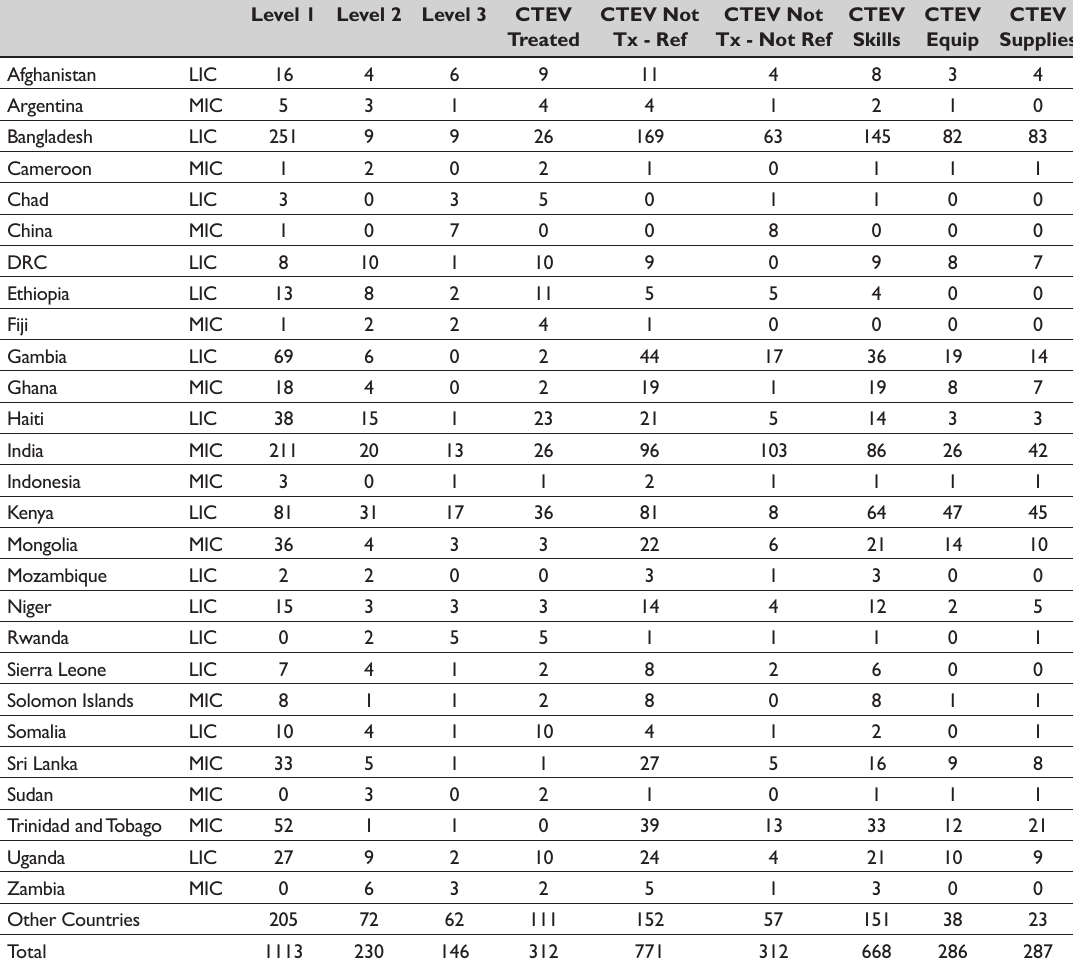
Table 2: Country Specific Breakdown of Level, CTEV Treatment, and Non-Treatment